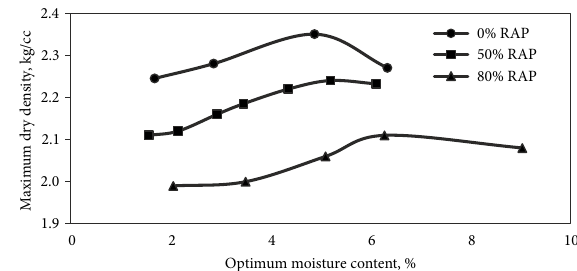
Figure 3. Variation of dry density of foamed bituminous mixtures with moisture